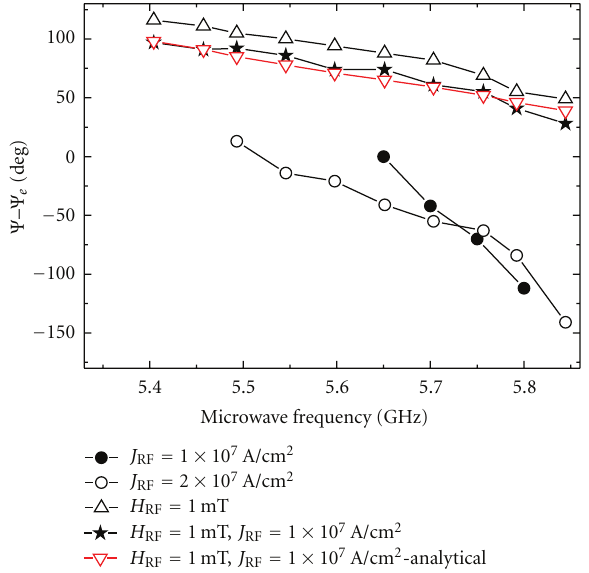
Figure 4: Intrinsic phase shift Ψ i between the phase of self- oscillation and microwave source (current or field) in the locking region for J DC = 5 × 10 7 A/cm 2